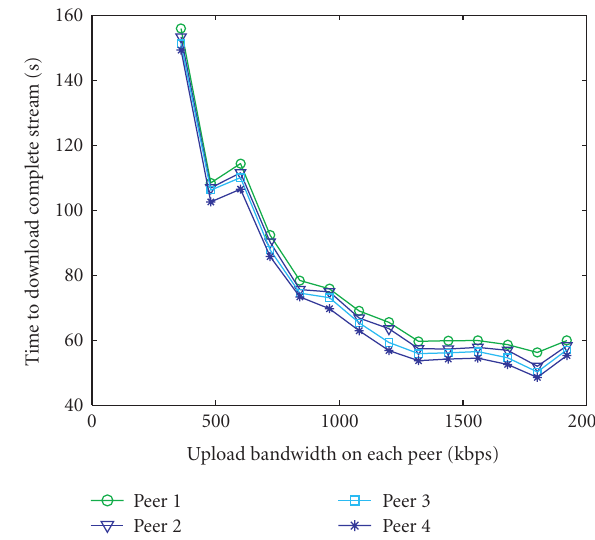
Figure 13: Time to download the complete stream (5.4 MB file) as a function of the upload bandwidth o ff ered by each peer.